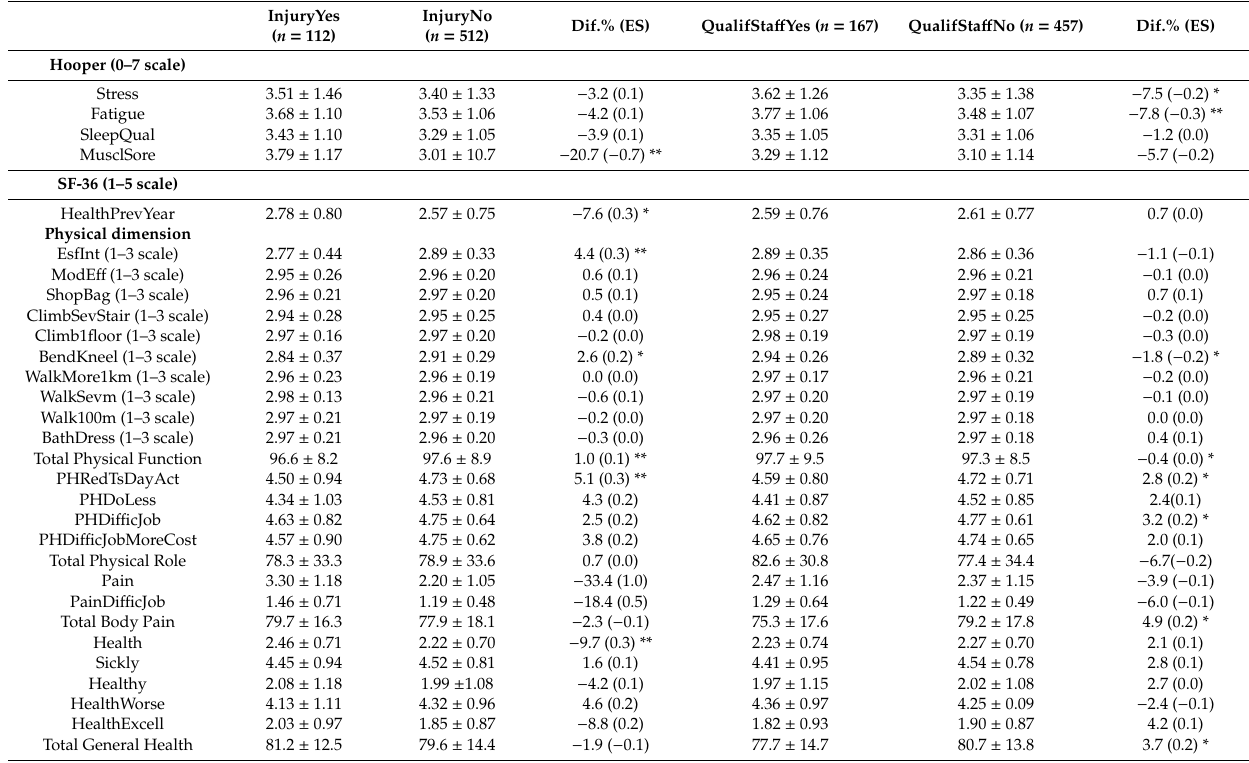
Table 4. Results obtained for the Hooper Index and for the Physical dimension of the SF-36 Questionnaire obtained by the amateur half-marathon runners participating in the study depending on whether they had su ff ered injury or not during the two months prior to participation in the race and depending on whether or not they had qualified sta ff for the preparation of the